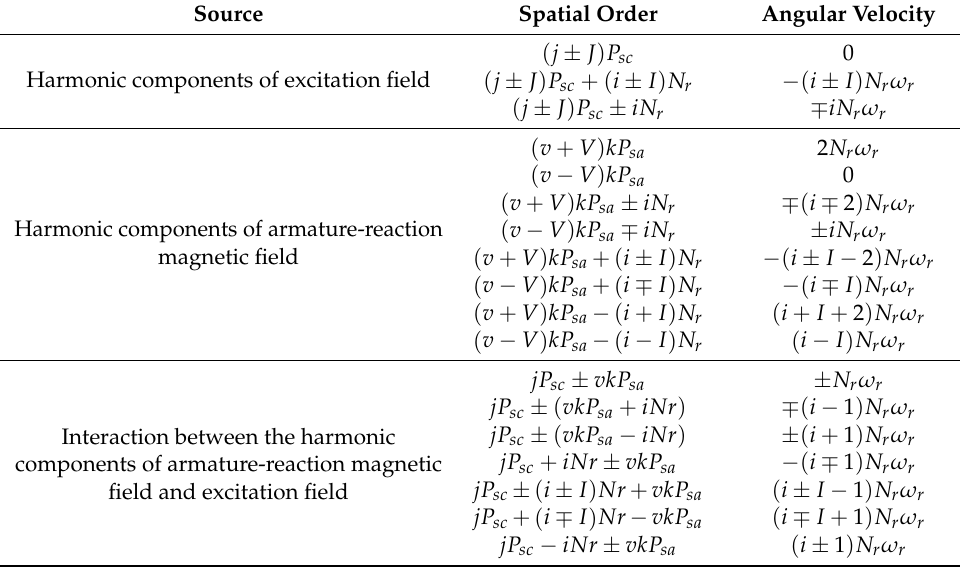
Table 1. Source, spatial order, and angular velocity of electromagnetic force density. Source Spatial Order Angular